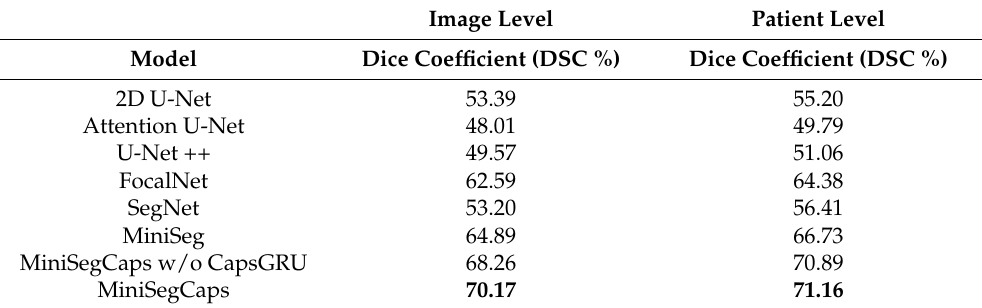
Table 3. Comparison of the image-level and patient-level performance between our method and baseline methods in prostate cancer segmentation (PI-RADS ≥